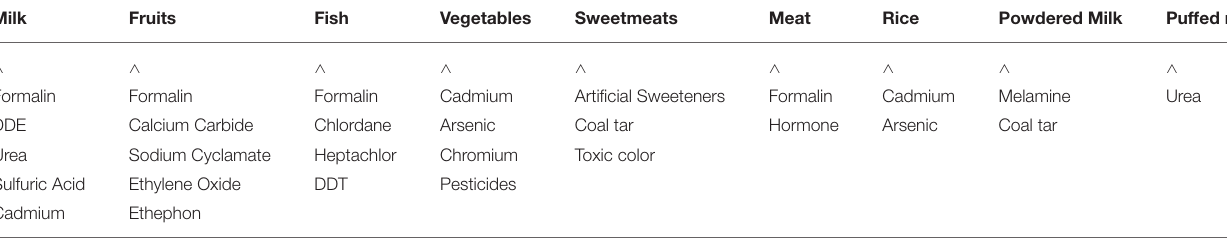
TABLE 2 | Food categories arranged according to the number of contaminants involved. Milk Fruits Fish Vegetables Sweetmeats Meat Rice Powdered Milk